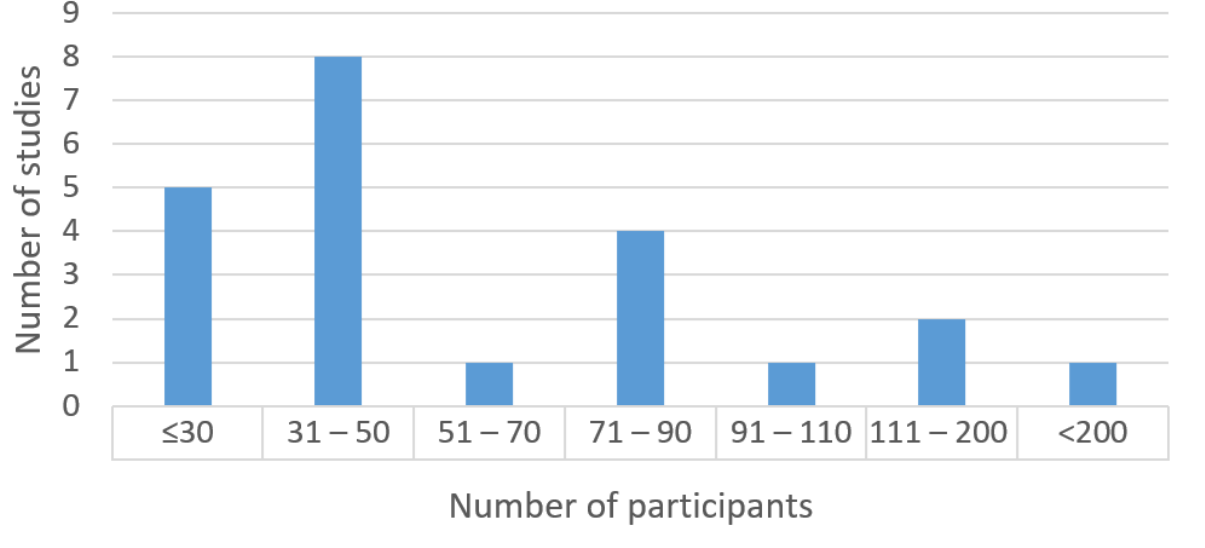
Figure 3. Distribution of number of participants in the selected